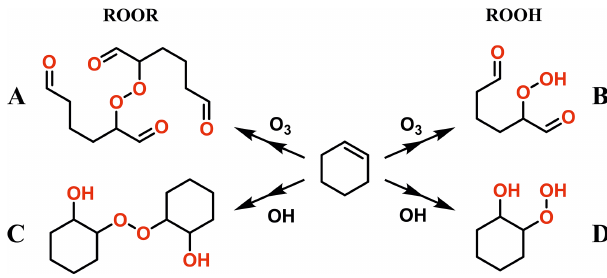
Figure 1. Investigated ROOR and ROOH species derived from ox- idation of cyclohexene by OH radical and O 3